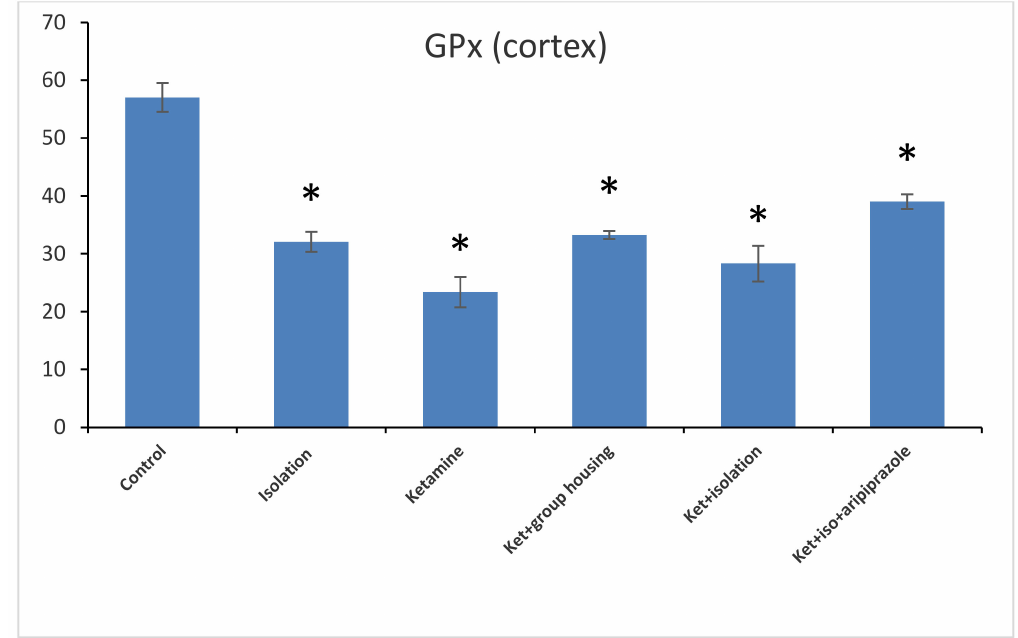
Figure 8. The effects of social isolation, ketamine, combined ketamine and social isolation, and combined ketamine, social isolation, and aripiprazole treatment on GPx-specific activity in cortex brain samples (measured in nmol/mg of protein). The values are mean ± SD ( n = 7 per group). * significantly different when compared to control group ( p <